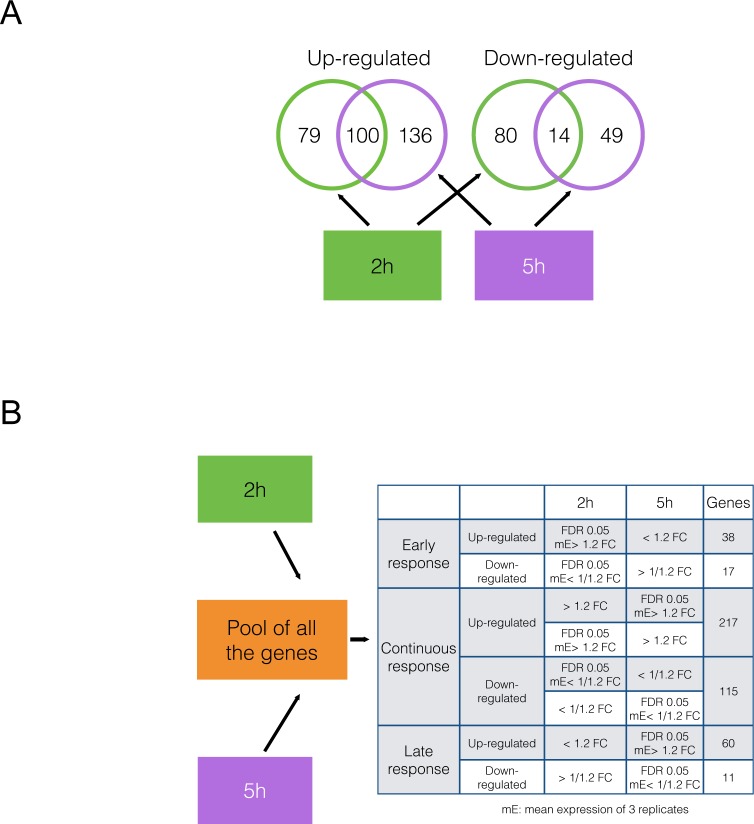
Methodological approach to analysis of DEGs identified during MET-induced sensory neuron ablation.Panel A: Venn diagram of up- and down-regulated DEGs present at 2 hrs (green) and 5 hrs (magenta) of MET exposure. The numbers of unique DEGs present either at one time point or found at both times are shown inside the circles. Panel B: Table listing the criteria for inclusion of genes shown in Panel A into one of three categories: early response, continuous response or late response. FDR = false-discovery rate (determined using Benjamini-Hochberg procedure); FC = fold-change.